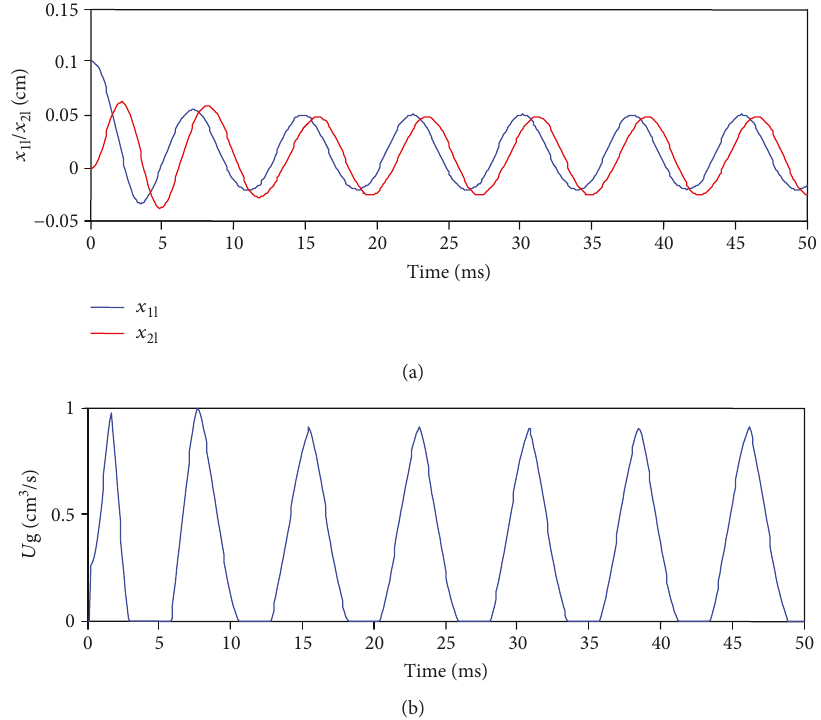
and x , resp.), and (b) 1l 2l